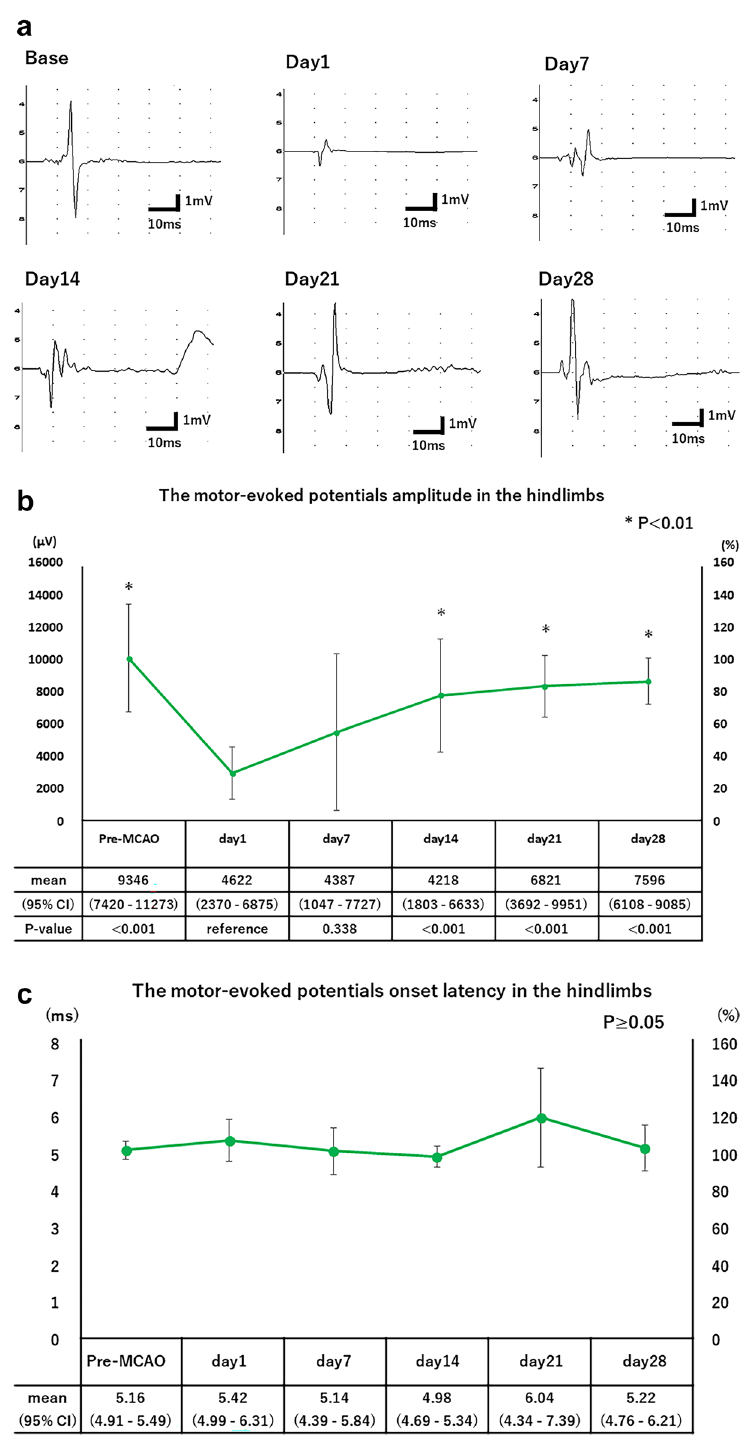
Figure 2. ( a ) Representative recordings of tcMEPs in the hindlimbs of rats were plotted before and at 1, 7, 14, 21, and 28 days after the MCAO procedure. ( b ) Time course of the motor evoked potentials amplitude in the hindlimbs. The left axis of the table shows the amplitude scale, and the right axis shows the percentage of the amplitude compared to the baseline value. Repeated measures analysis of variance was performed on the weekly measurements. Student-t tests with Bonferroni correction were performed for outcomes with significant one-way analysis of variance. *P < 0.01. ( c ) Time course of the motor evoked potentials onset latency in the hindlimbs. The left axis of the table shows the onset latency scale, and the right axis shows the percentage of the amplitude compared to the baseline value. Repeated measures analysis of variance was performed on the weekly